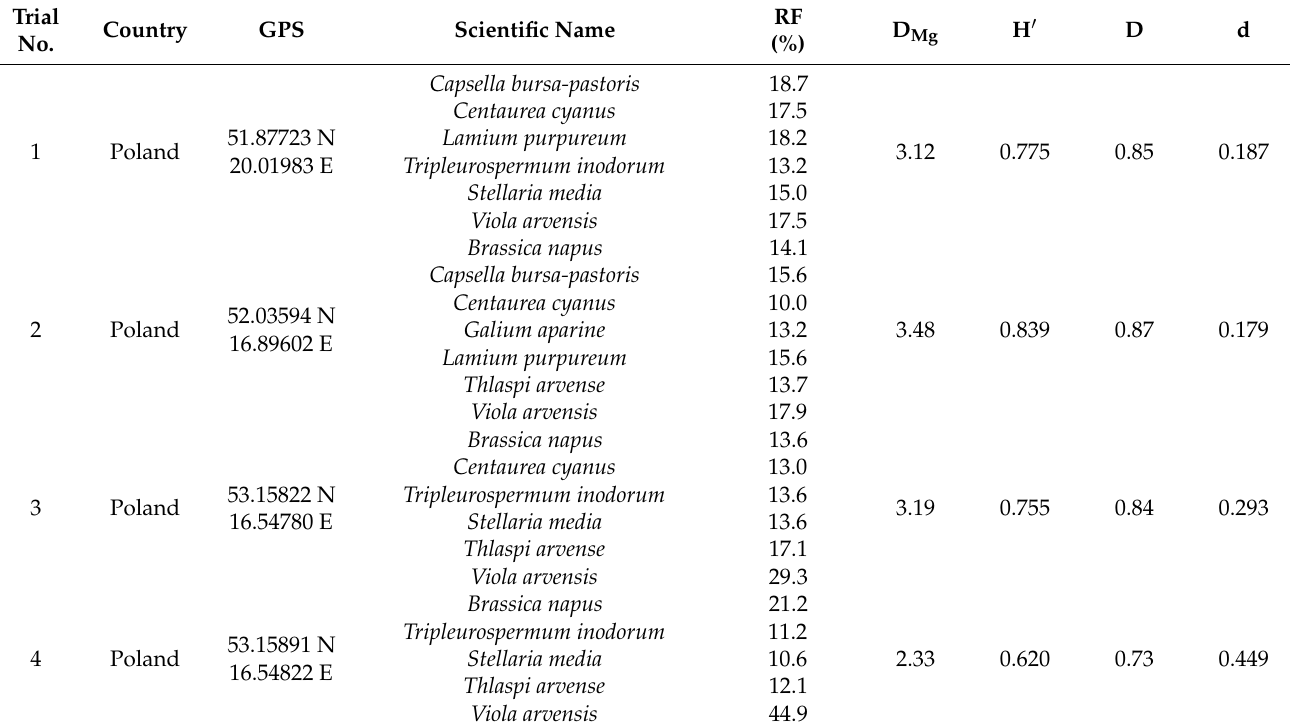
Table 3. Indicates of weed community biodiversity at individual